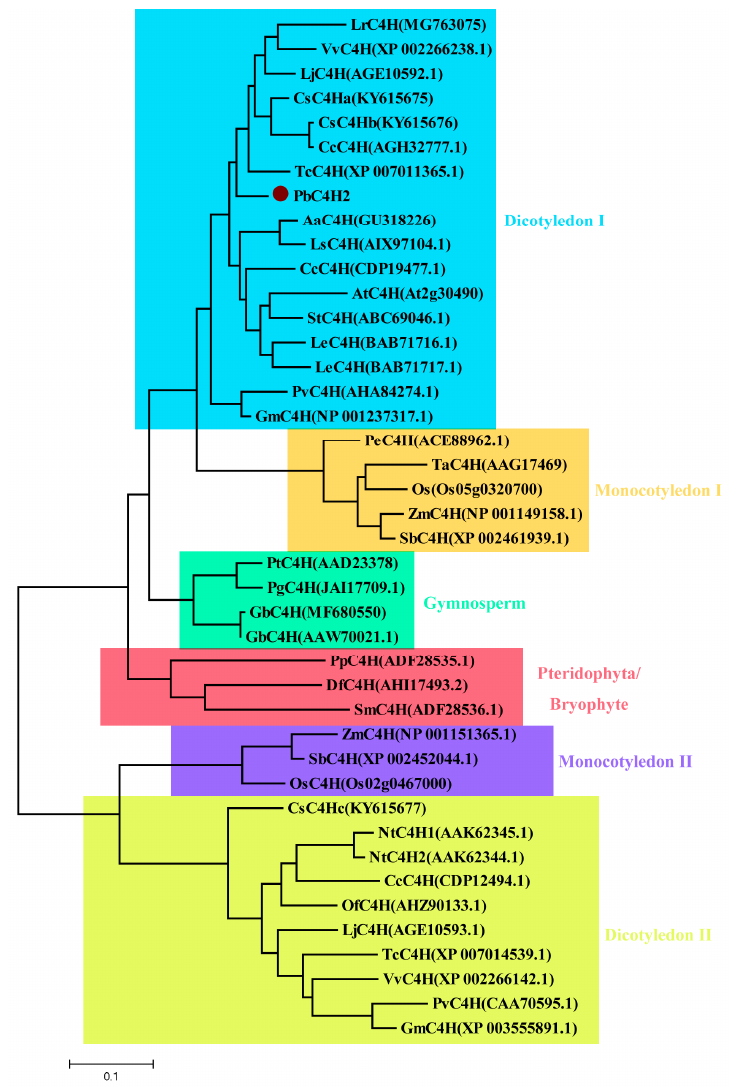
Figure 9. Phylogenetic tree of C4H protein sequences from various plants. Protein sequences were aligned, and a phylogenetic tree was constructed by the maximum likelihood (ML) method using MEGA 5.1 software (Arizona State University, Phoenix, USA).